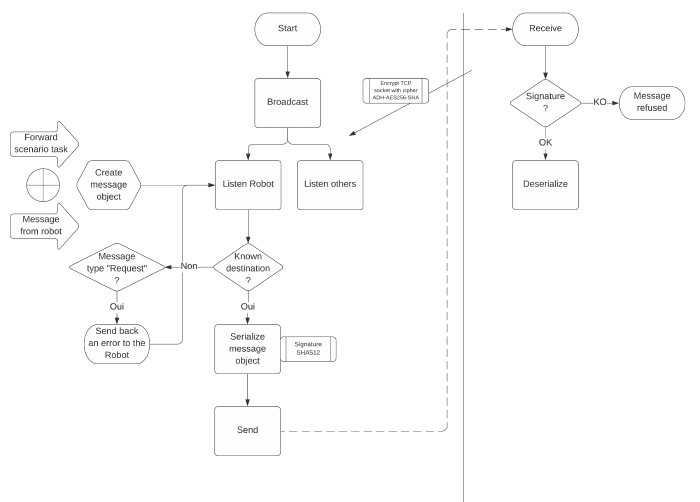
Figure 6. Exchange between two embedded